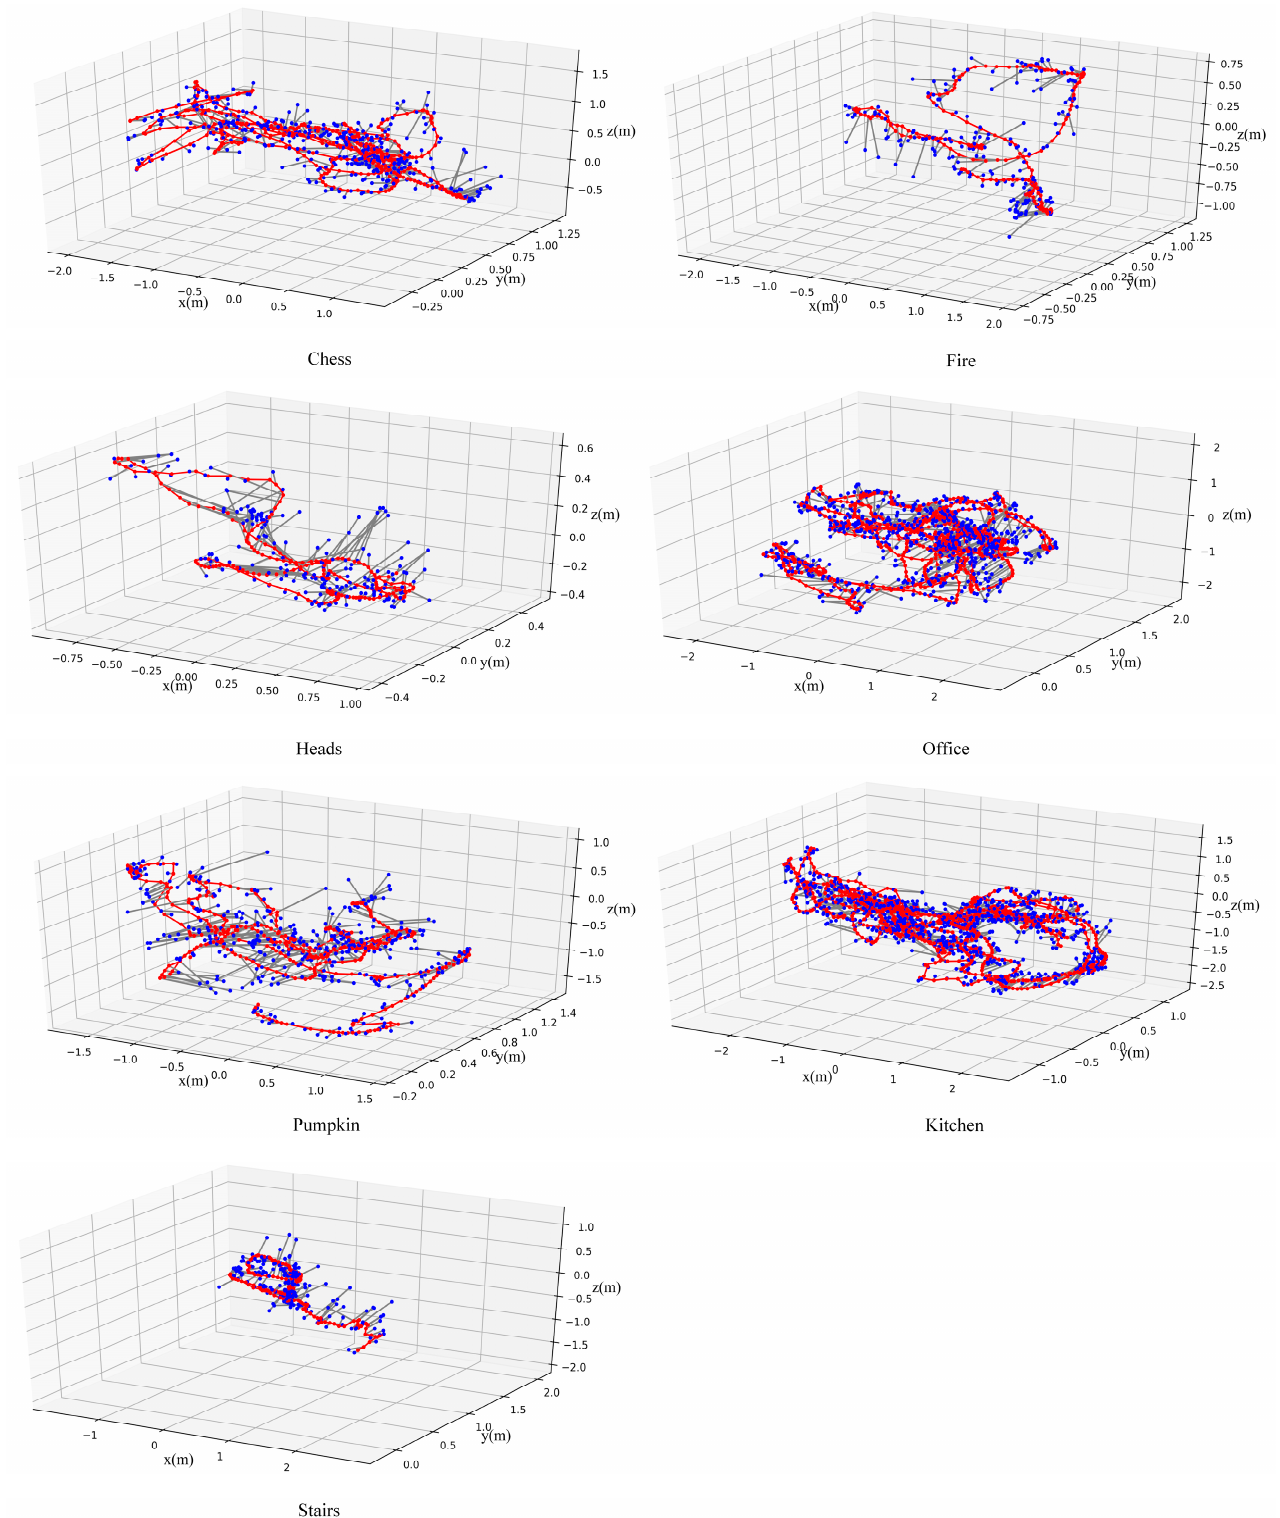
Figure 8. Localization for testing (blue) and training (red) data from the 7-Scenes data set. The red line is the trajectory of the ground-truth of the test image, and the black line represents the difference between the calculated by result and the ground-truth.